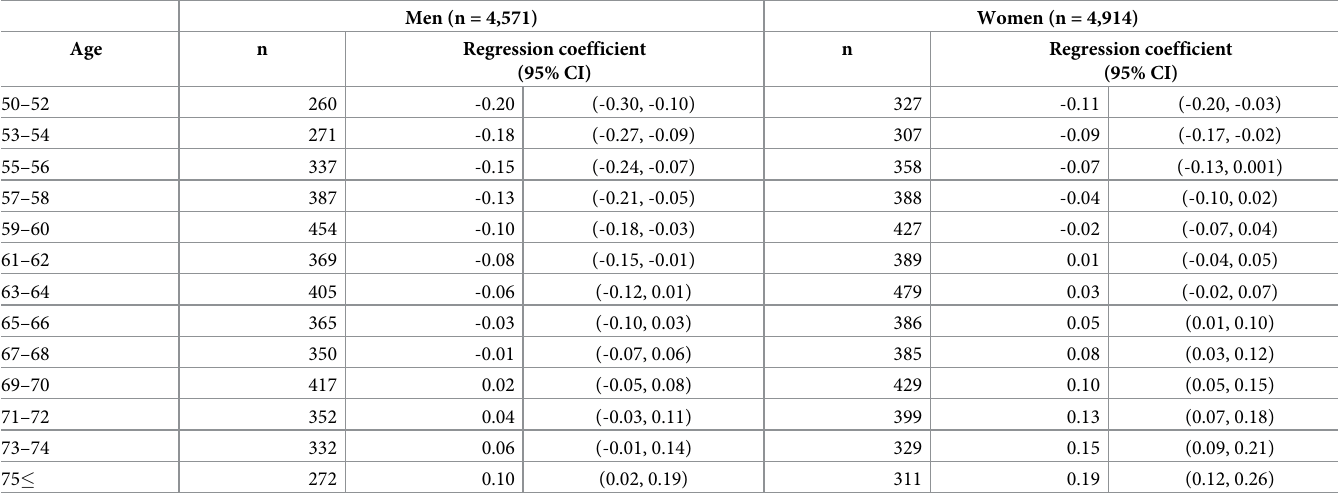
Table 2. Adjusted marginal effect for grip strength per unit of energy-adjusted protein